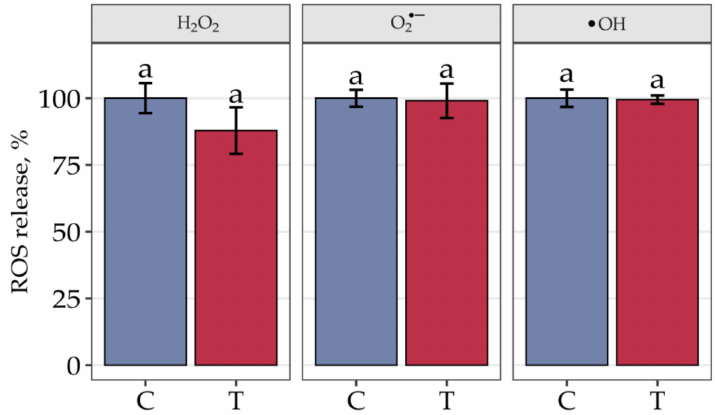
Figure 1. The release of three types of ROS hydrogen peroxide (H 2 O 2 ), superoxide anion radical (O 2 •− ) and hydroxyl radical ( • OH) in embryonic axes of pedunculate oak control seeds (C) and seeds subjected to thermotherapy (T). The data are the means of six independent replicates ± the SE. The same letters indicate groups that are not significantly different according to Tukey’s